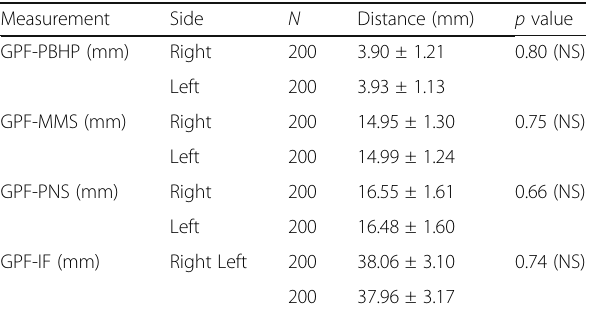
Table 9 Measurements taken from the GPF based on side Measurement